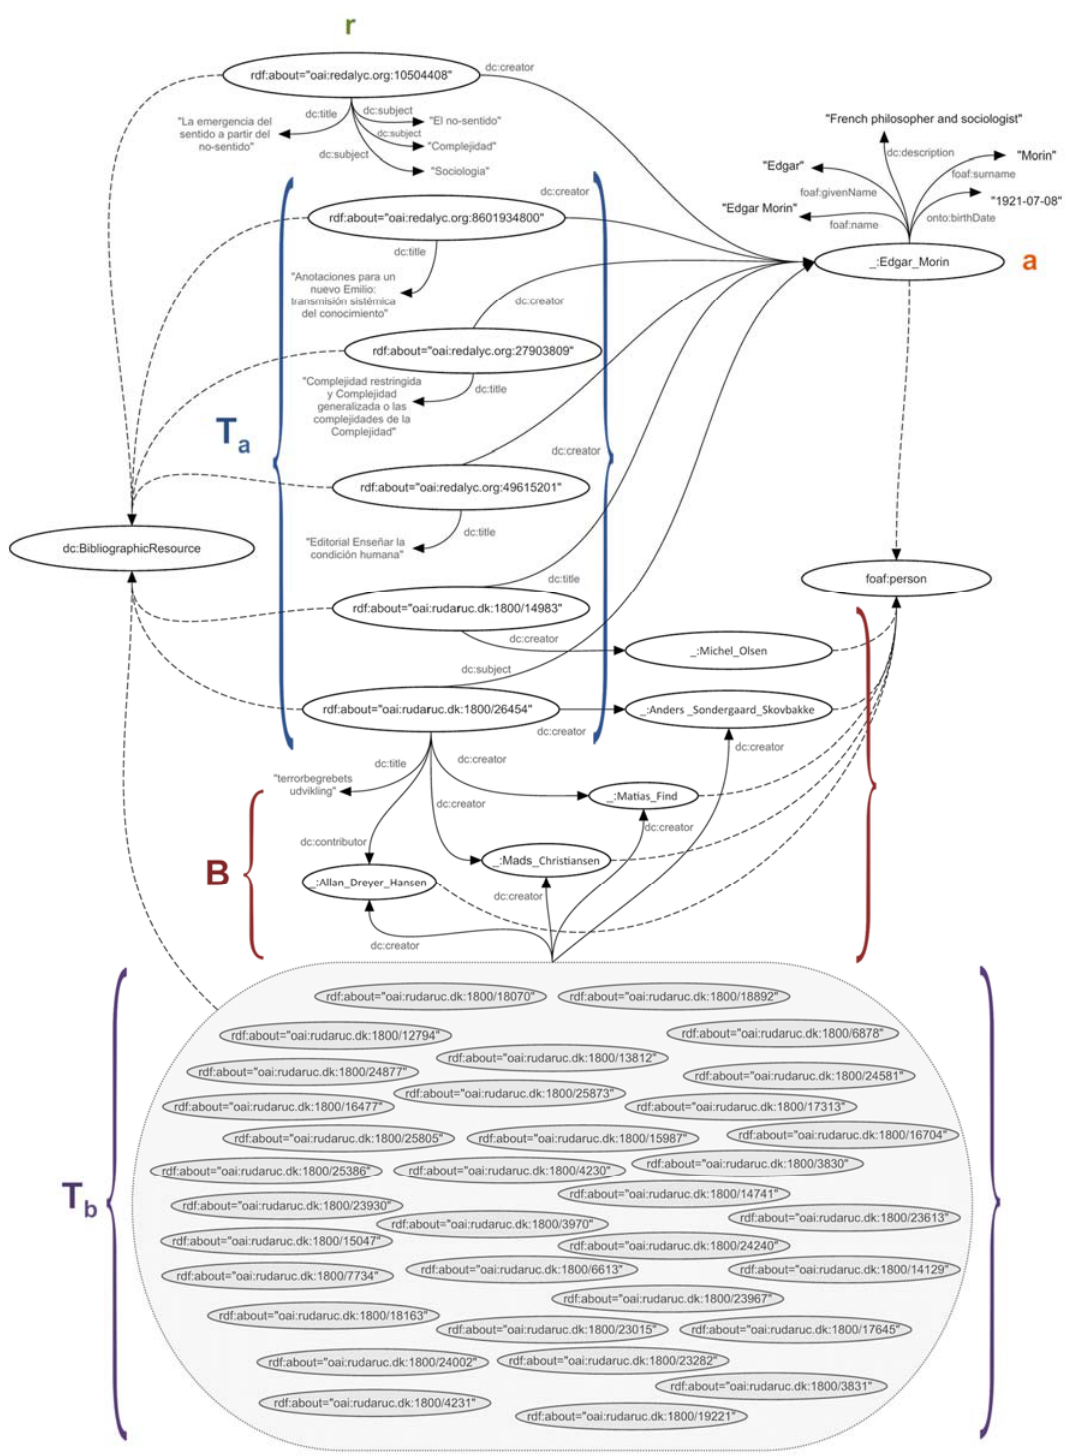
Figure 14. Selective knowledge discovery from the example.